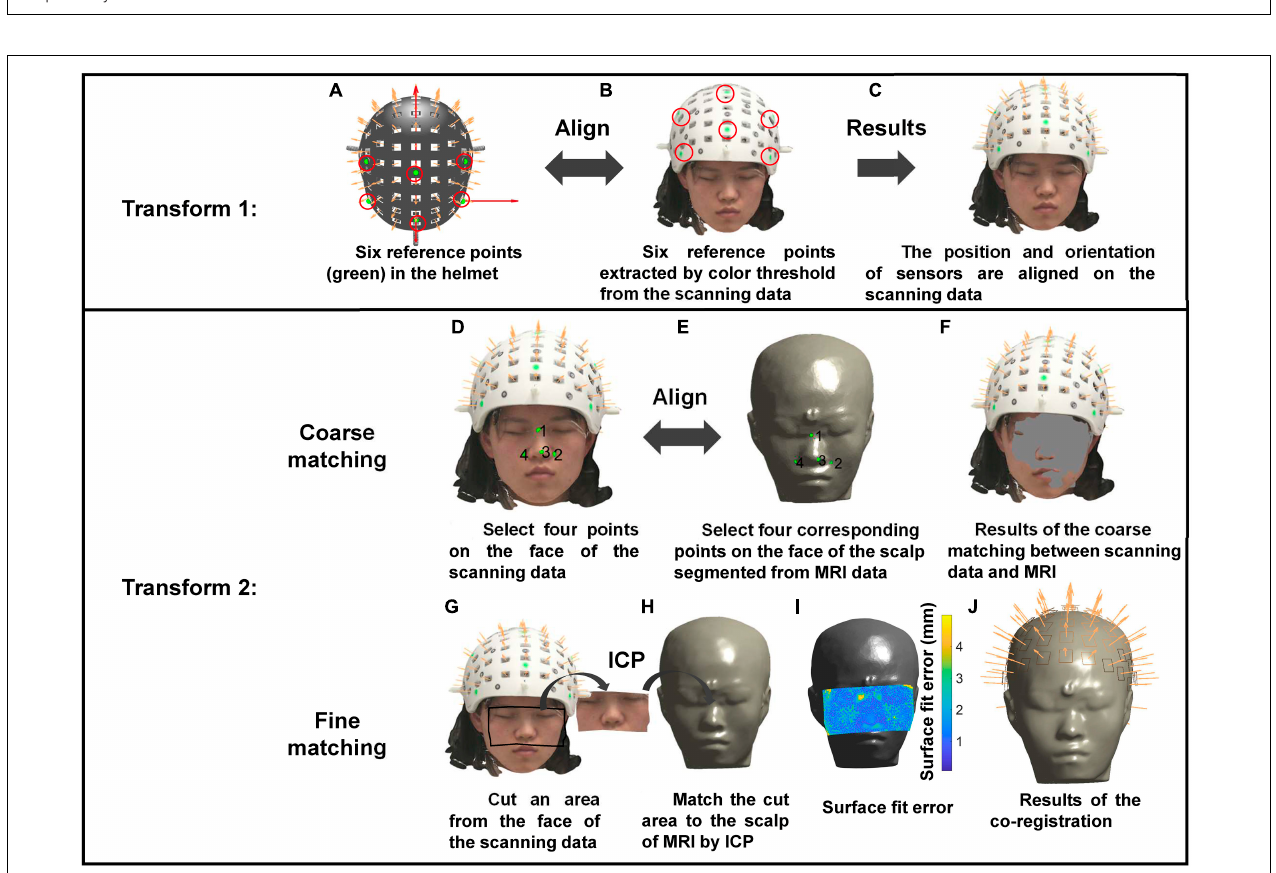
FIGURE 2 | The operation process of the co-registration using Polhemus. Transform 1: Align the positions of the six reference points between the MEG-Device coordinate system (A) and the MEG-Head coordinate system (B) to let the sensor positions and orientations be aligned on the digitized points (C) . Transform 2: Use the ICP algorithm to fit the digitized points onto the MRI. (D,E) The initial relative positions between digitized points and MRI and relative positions after ICP, respectively.